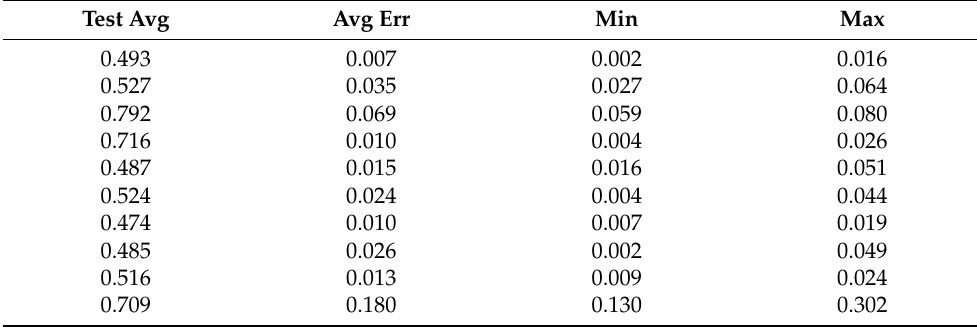
Table A7. Set 1, trials 1–10 data (all 0.5 PR values).